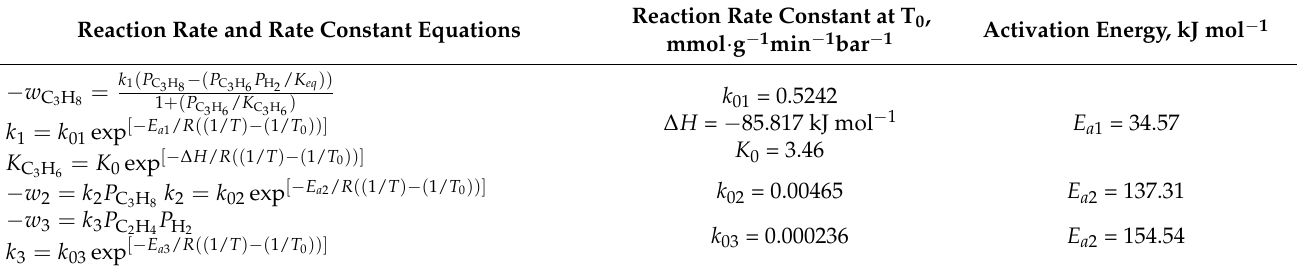
Table 2. The kinetic parameters for the propane dehydrogenation process used for the modeling. Reaction Rate Constant at T 0 Reaction Rate and Rate Constant Equations